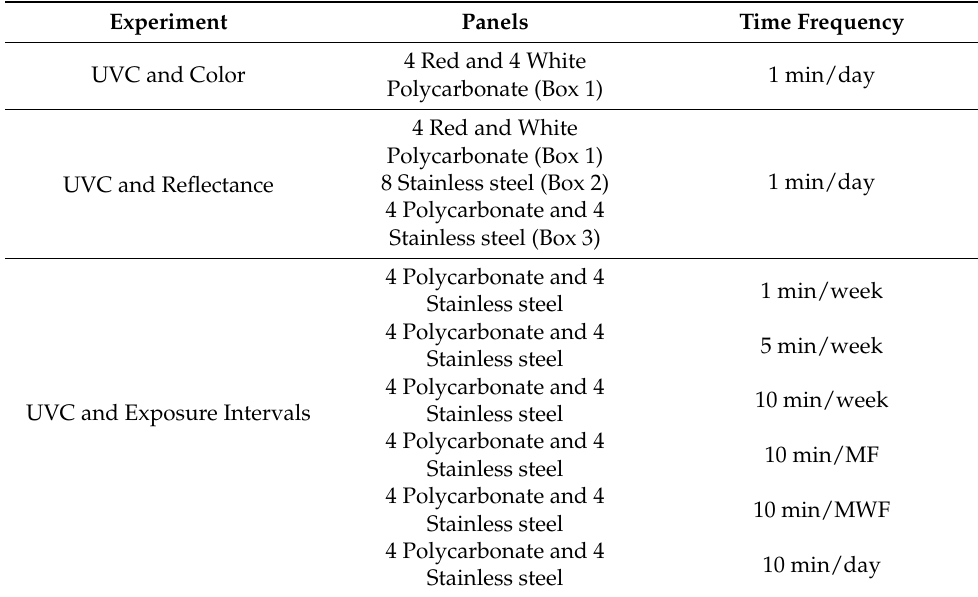
Figure 1. A visual representation of the UVC box set up. The sides of the box were composed of two epoxy backing plates (10 cm × 20 cm) with 3D printed caps that allowed for the lamp to be held in place. The photos in this figure reflect the box prior to the insertion of panels. Each box housed eight panels, four on either side, placed 25 mm from the lamp source. Table 1. A summary of the experiments conducted with the number and type of substrate and the time